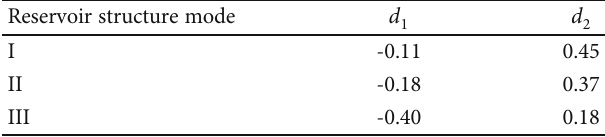
, d of Equation (15) in Akpo oil fi elds. 1 2